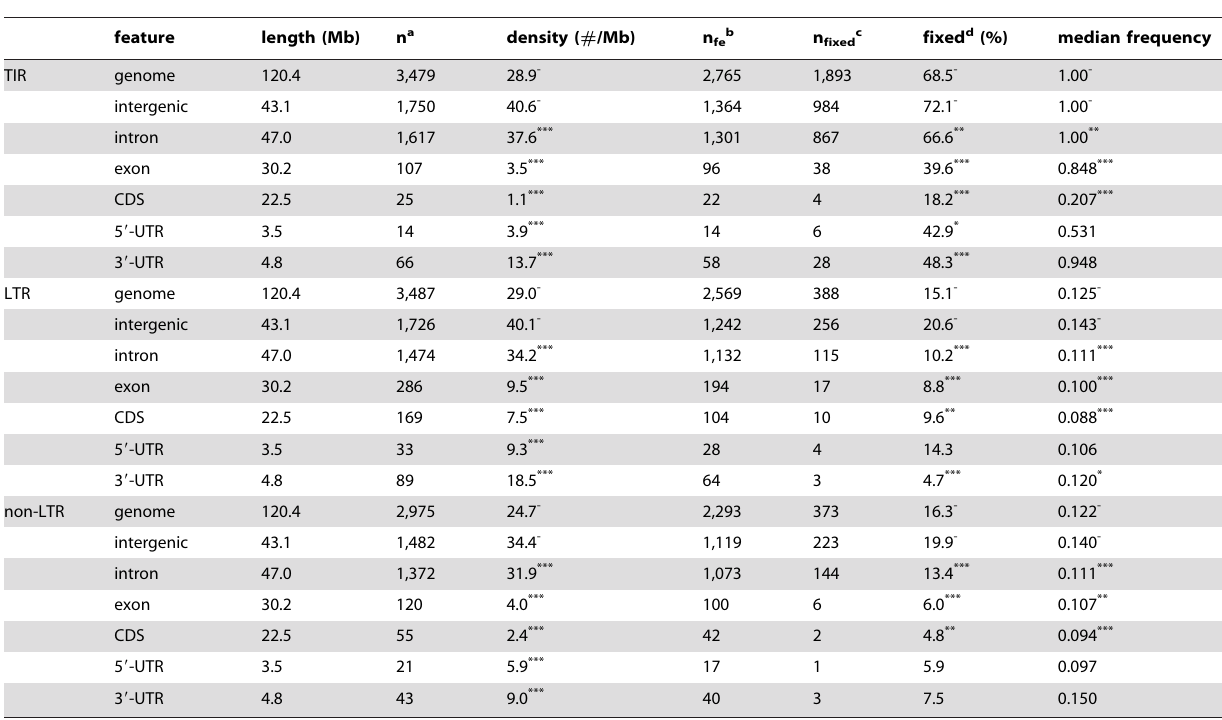
Table 2. Abundance of TE insertions in different features of the D. melanogaster